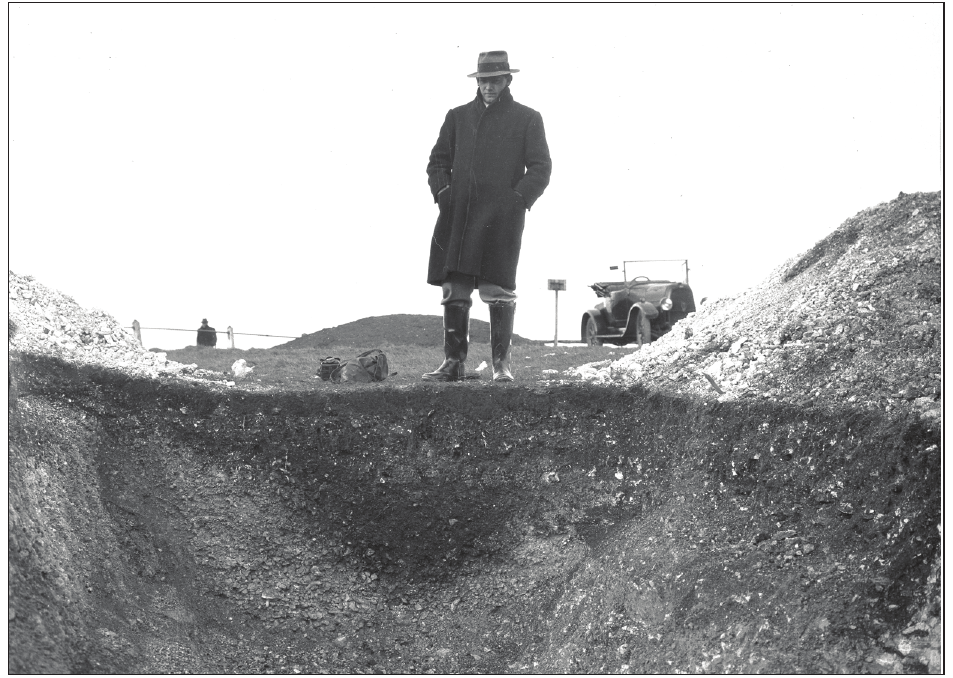
Figure 1: ‘Whitehawk: Inner Ditch’. From Whitehawk Slide Show of Curwen images from the Sussex Archaeological Society, Whitehawk Camp Community Archaeology Project via Image Store. Photo © The Sussex Archaeological